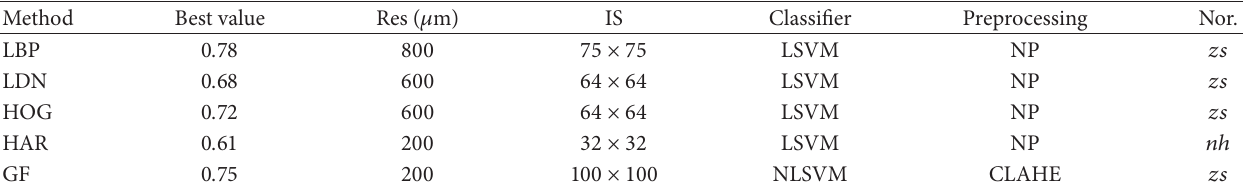
Table 4: Best AUC value for each texture analysis method and the configuration that yields it considering the experiments in Sections 3.1, 3.2, and 3.3.